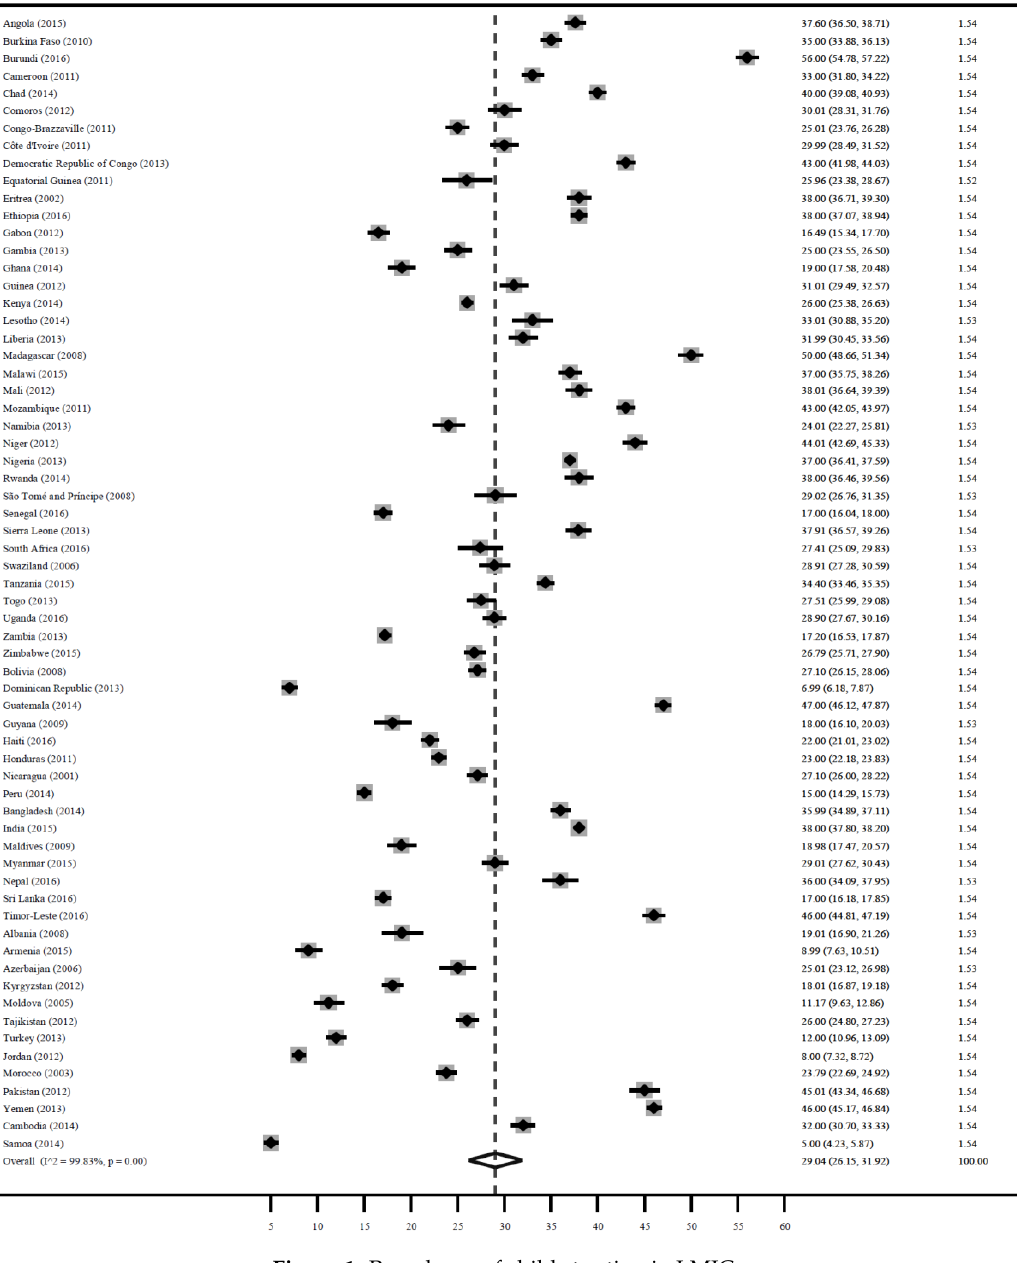
Figure 1. Prevalence of child stunting in LMICs.